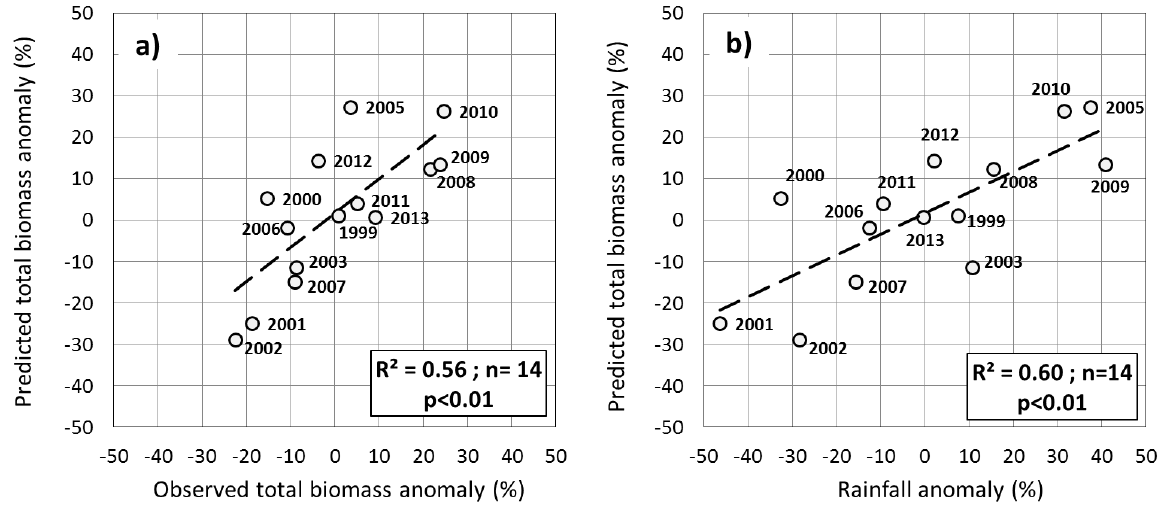
Figure 7. Total biomass estimates for ( a ) 2002 in deficit and ( b ) 2010 in surplus, given by the early warning model (Model_EW).